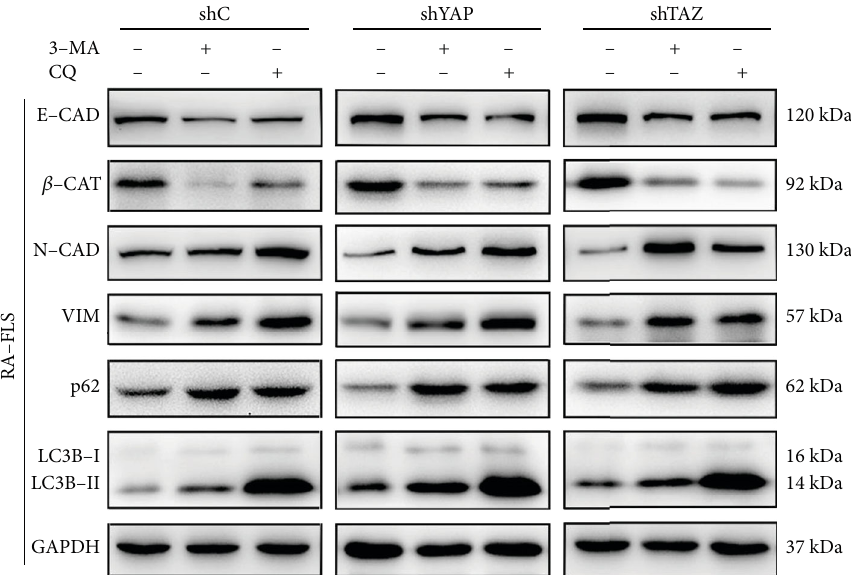
Figure 7: E ff ect of autophagy inhibition on the expression of the indicated genes in stable YAP or TAZ knockdown RA-FLS. The indicated proteins in cellular extracts were determined by western blot from RA-FLS in the presence or absence of 3-MA (10 mM) or CQ (30 μ M). GAPDH was used as a loading control. Representative blots are shown ( n = 3